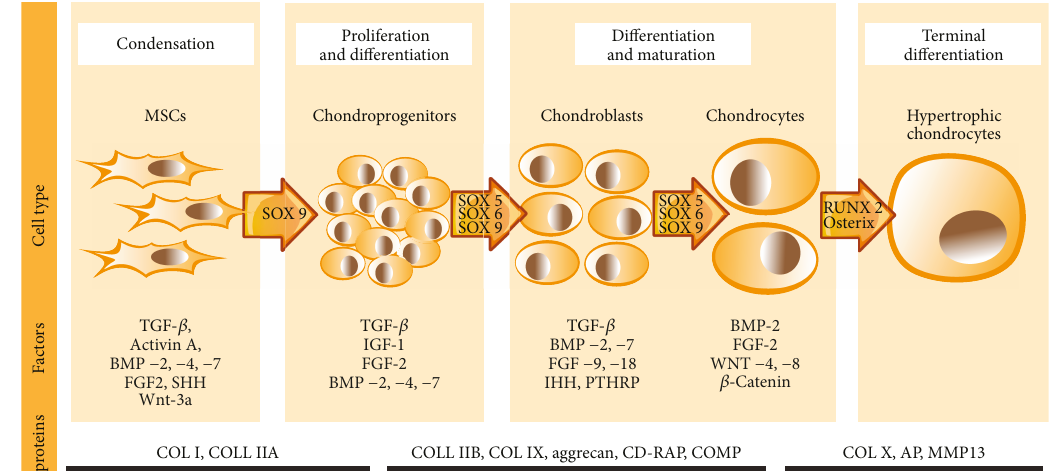
Figure 3: Stages of chondrogenesis in